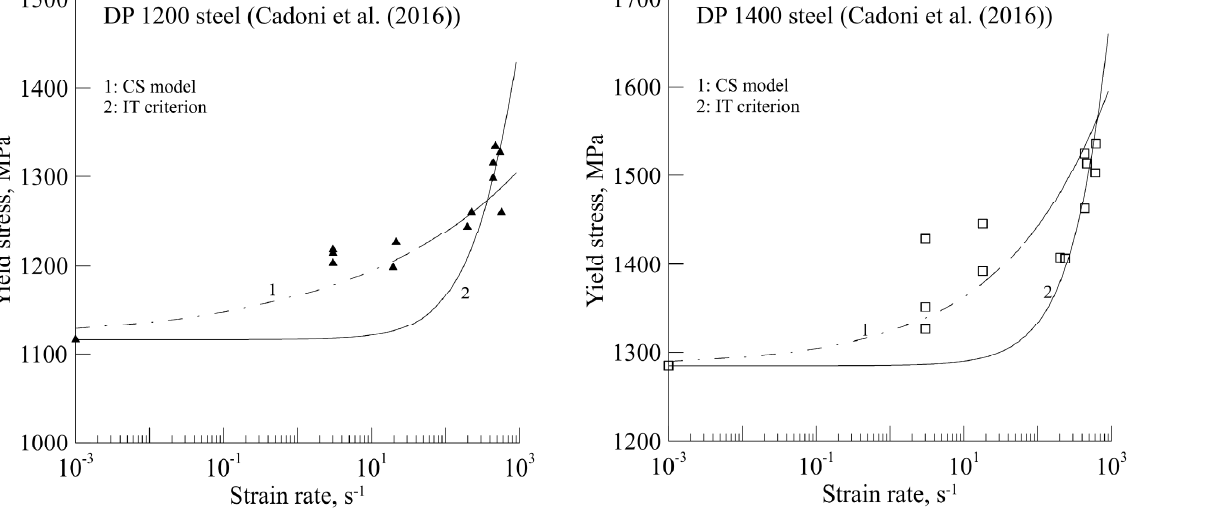
Fig. 1. Rate dependence of yield stress of DP1200 steel (data from [47]), plotted on CS model (1 line) and IT criterion (2 line).